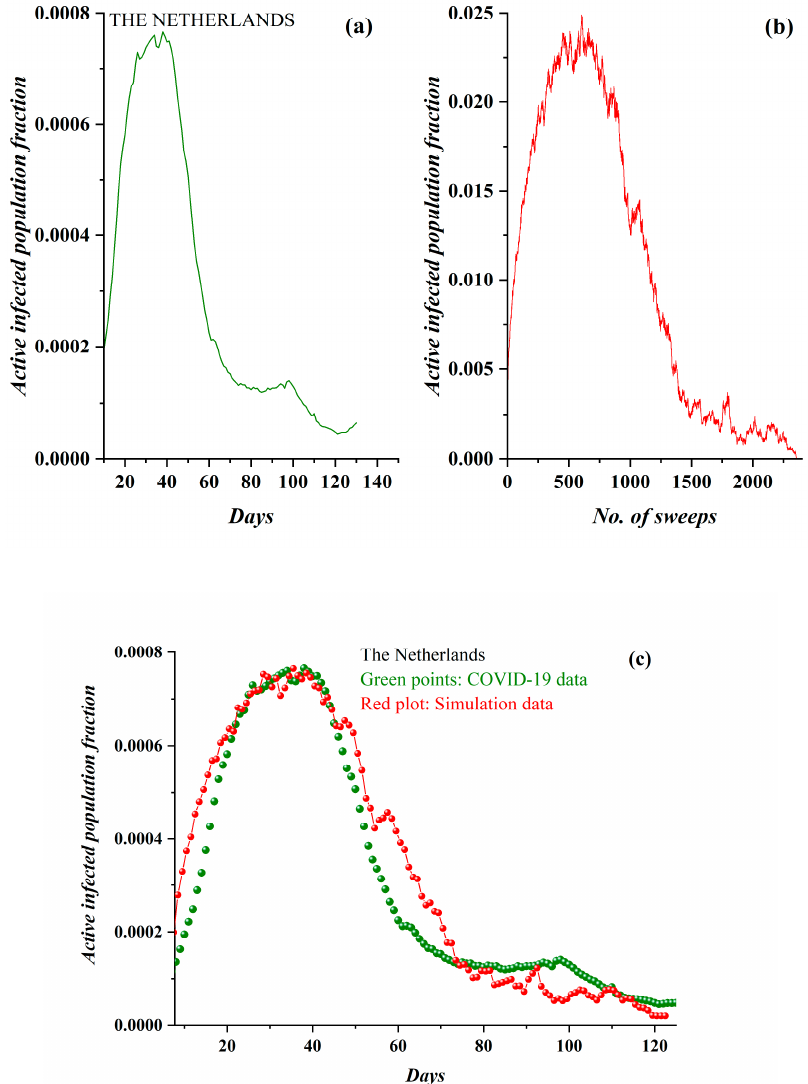
Figure 7. ( a ) The fraction of the daily active COVID-19-infected Dutch population (after 10 March 2020). The three described phases are clearly distinguished. ( b ) The fraction of active lattice sites (order parameter of the SODM) vs. the number of lattice sweeps is shown. ( c ) The COVID-19 epidemic data for the Netherlands in green points, fitted by the proposed SODM simulation data, in red points. Each day corresponds to 21 sweeps.